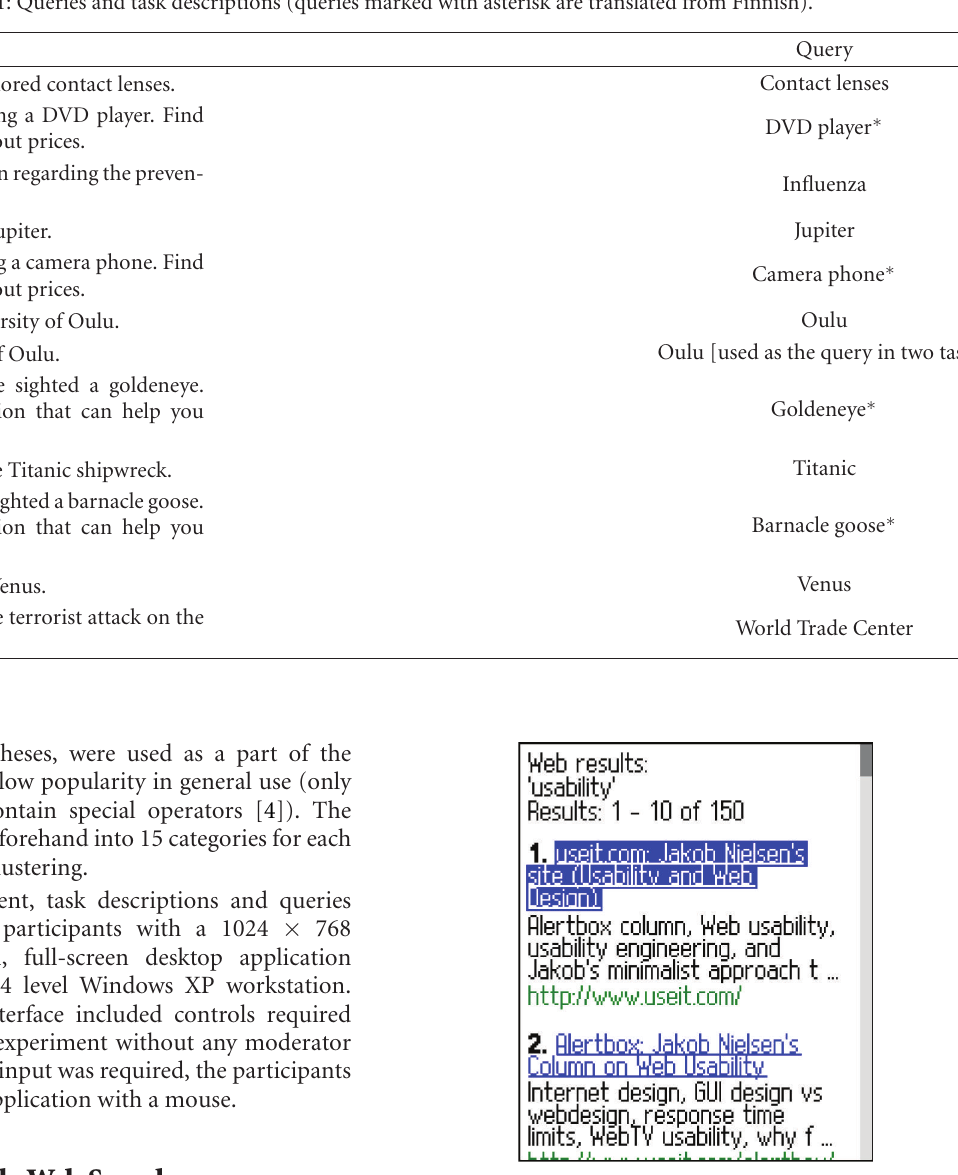
Figure 2: Reference UI showing the first page of